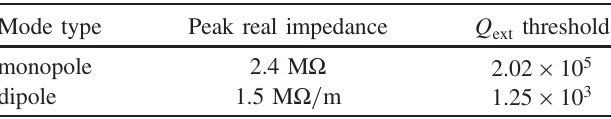
based on HL-LHC data [3]. ext